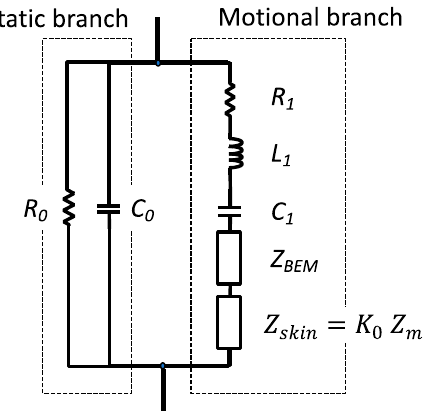
Figure 2. BVD Electrical modelling of the TSM sensor in contact with the skin explant. The equivalent system includes a static branch and a motional branch. These two branches represent the electromagnetic and the electromechanical properties of the loaded transducer by the skin explant immersed in the nutritional liquid BEM, respectively. Table 3. BVD Lumped elements and intrinsic characteristics of unloaded TSM sensor [55,56]. TSM Parameters and Electrical